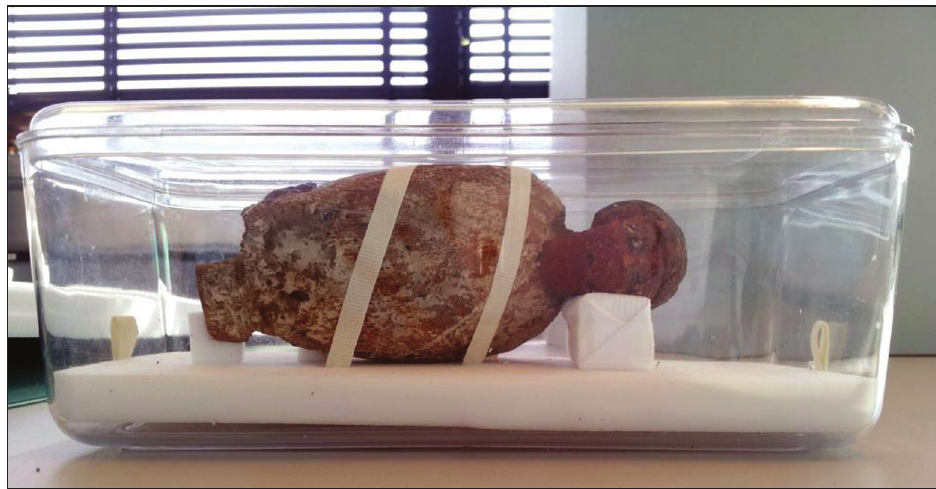
Figure 2: The boatman figurine packaged for handling. By lying on his side the termite damage remains clearly visible (Photo Carmen